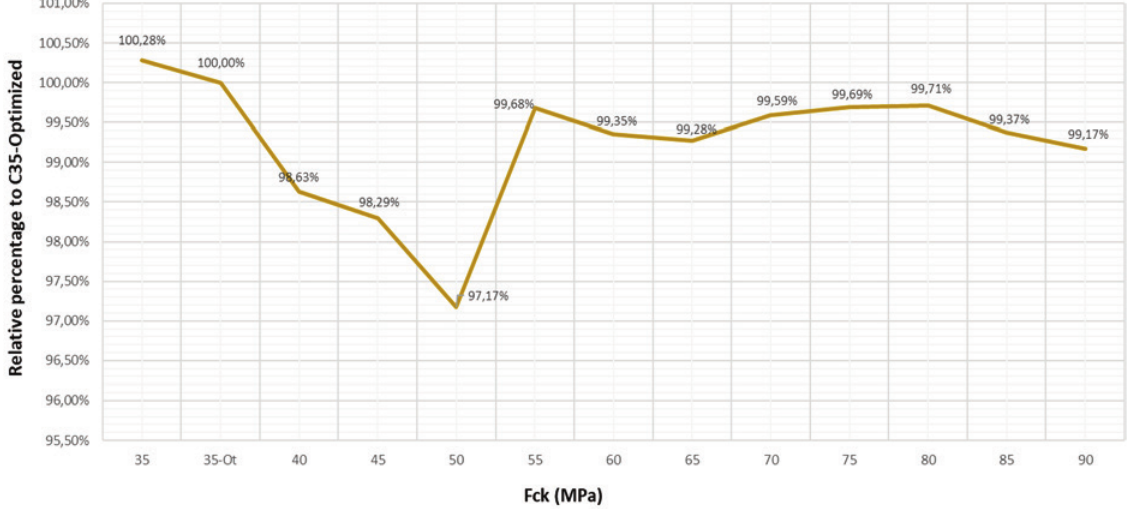
Variation of the costs of the structure in relation to the